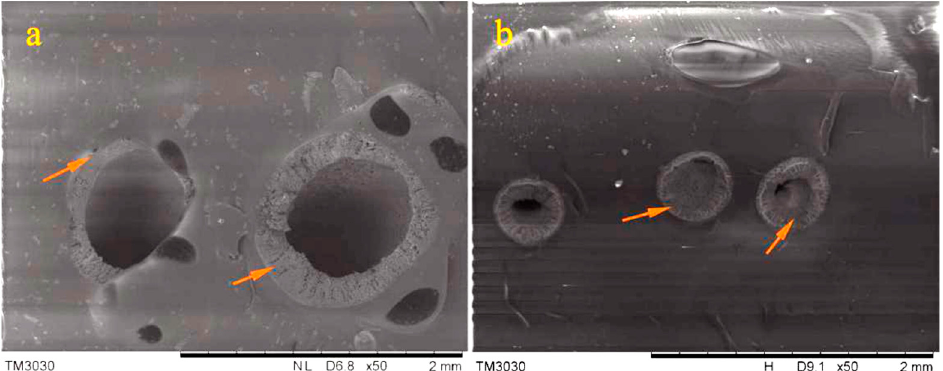
Figure 4. SEM interface morphology of microvasculars in asphalt sample, ( a ) hollow microvasculars without oily rejuvenator tightly connected with the asphalt material, ( b ) interface morphology of the microvasculars containing rejuvenator in the asphalt.